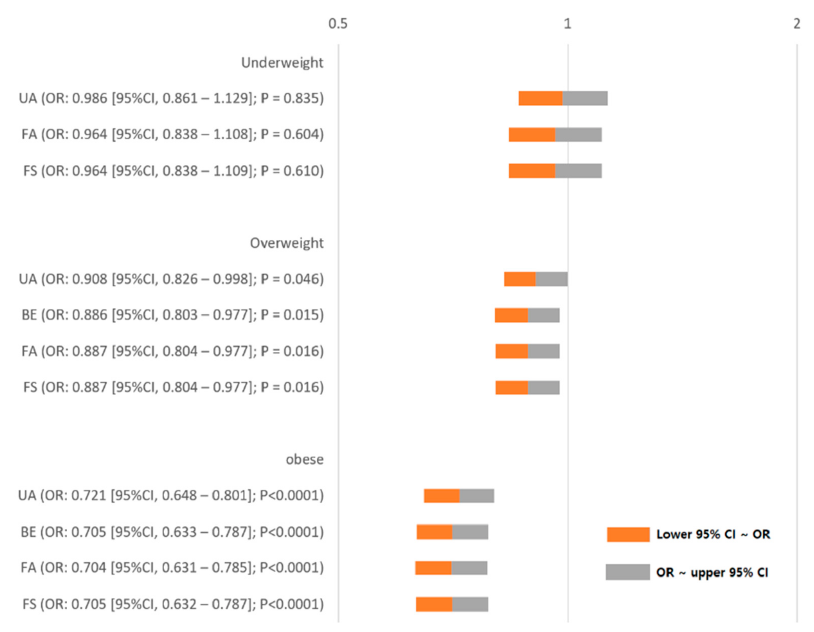
Figure 2. ORs for development of PONV in underweight, overweight, and obese patients. UA,